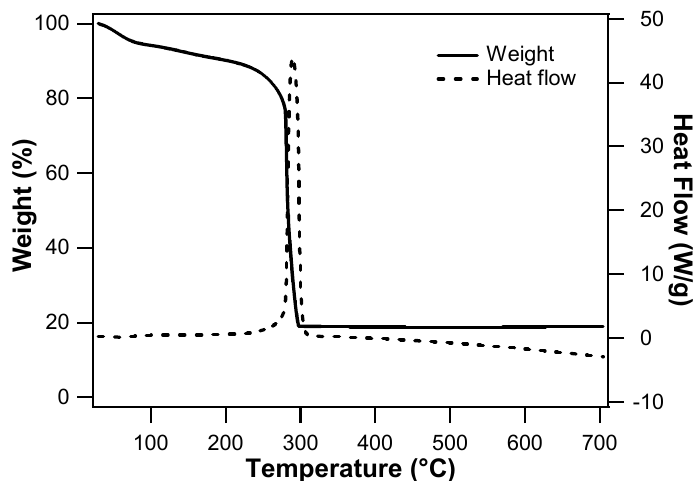
Figure 2. Thermogravimetric analysis and differential scanning calorimetry graph for as-spun IrCl 3 / PVP nanofibers obtained in air, with temperature increasing rate of 5 ◦ C · min − 1